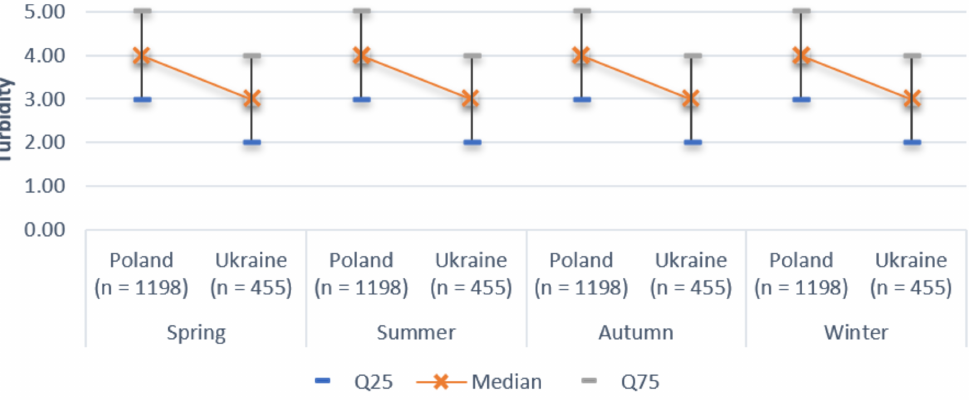
Figure 6. Turbidity assessment of tap water during individual periods of the year by groups of respondents from Poland and Ukraine.